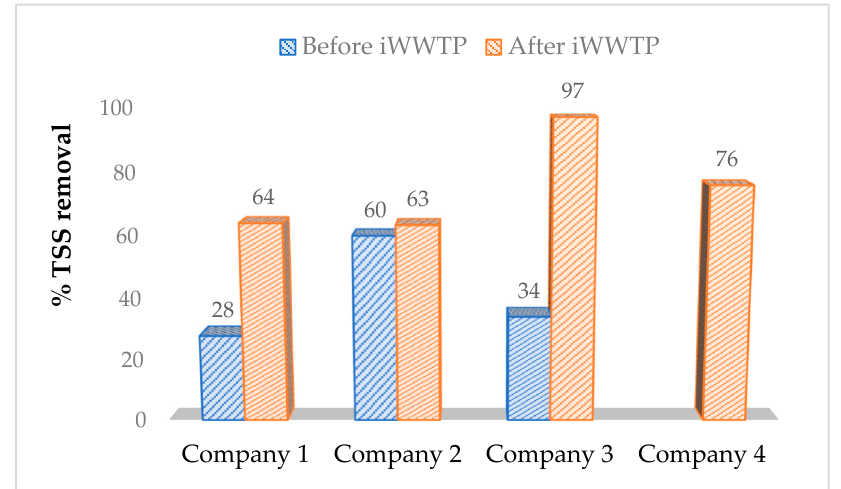
Figure 5. % TSS removal before and after the iWWTP.